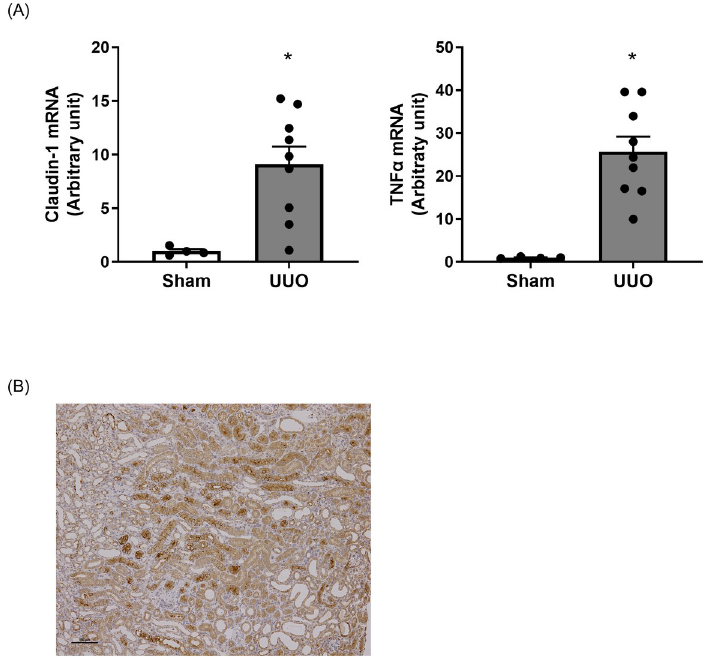
Fig 7. Elevation of CL-1 and TNF- α in the kidney of UUO mice. The mRNA expression levels of CL-1 and TNF- α were significantly elevated in UUO mice (A). Representative immunohistochemical images of CL-1 in the kidney of UUO mice. CL-1 was strongly stained in proximal tubular cells. Scale bar indicates 100 μ m (B). Relative mRNA expression was calculated as the ratio to GAPDH expression. The actual values are represented as dots, and the columns represent mean + SE. � p < 0.05, significant difference versus sham (Student’s t-test). Sham: sham operated mice, UUO: UUO mice.